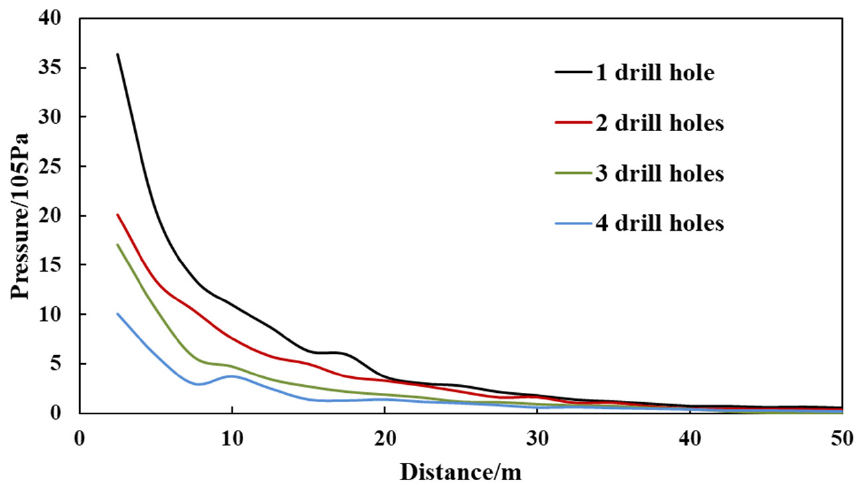
Figure 7. Verification of simulation results.